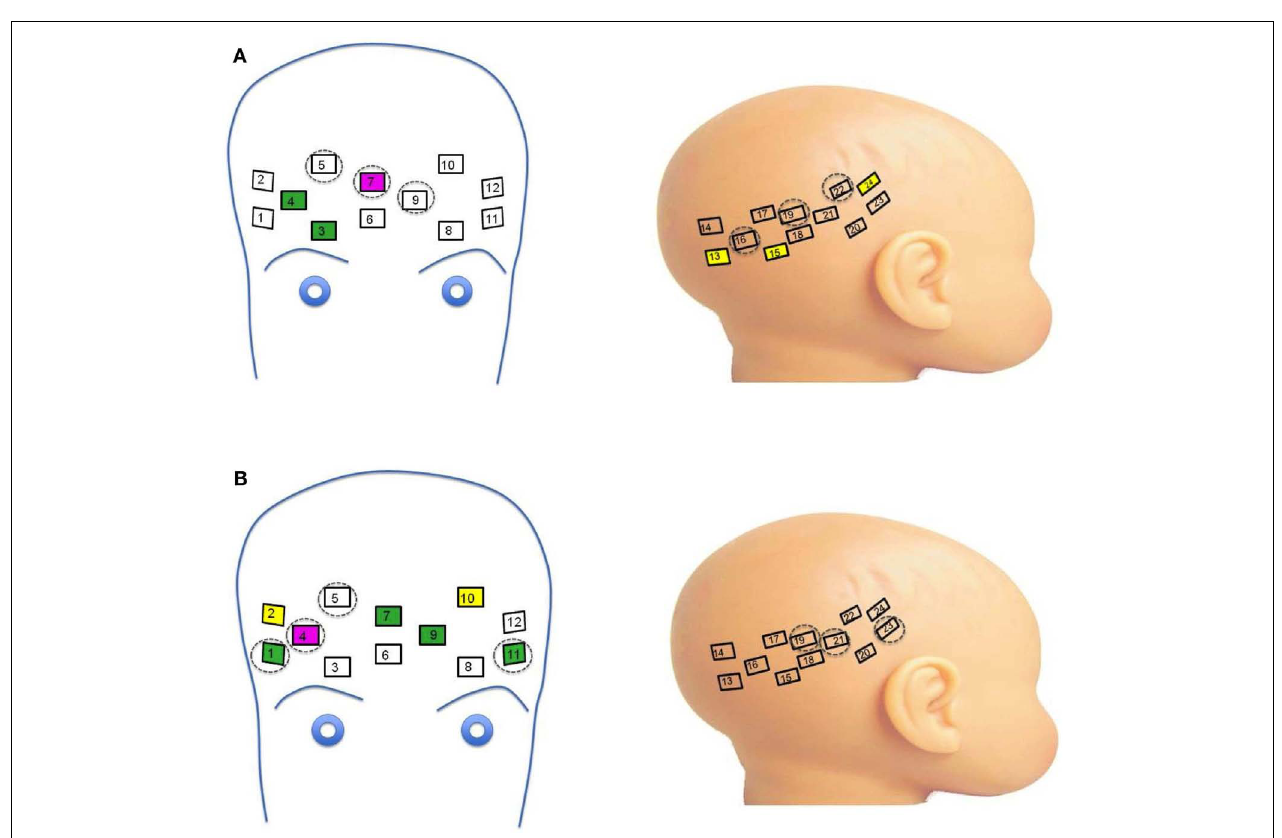
(B) Channels significant for main effects and interactions on deoxy-hemoglobin response. Channels with main effects of Face Identity (magenta), Emotion (green), and Group occurred in frontal regions, while significant interactions were seen across frontal and lateral channels neighboring those significant for oxy-hemoglobin responses (dashed